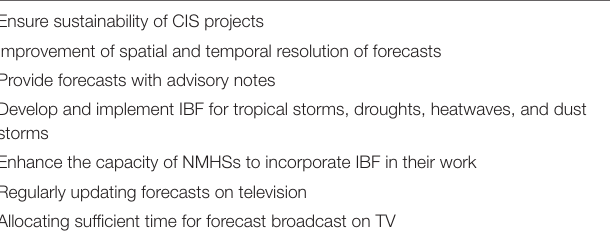
TABLE 4 | Key recommendations from the